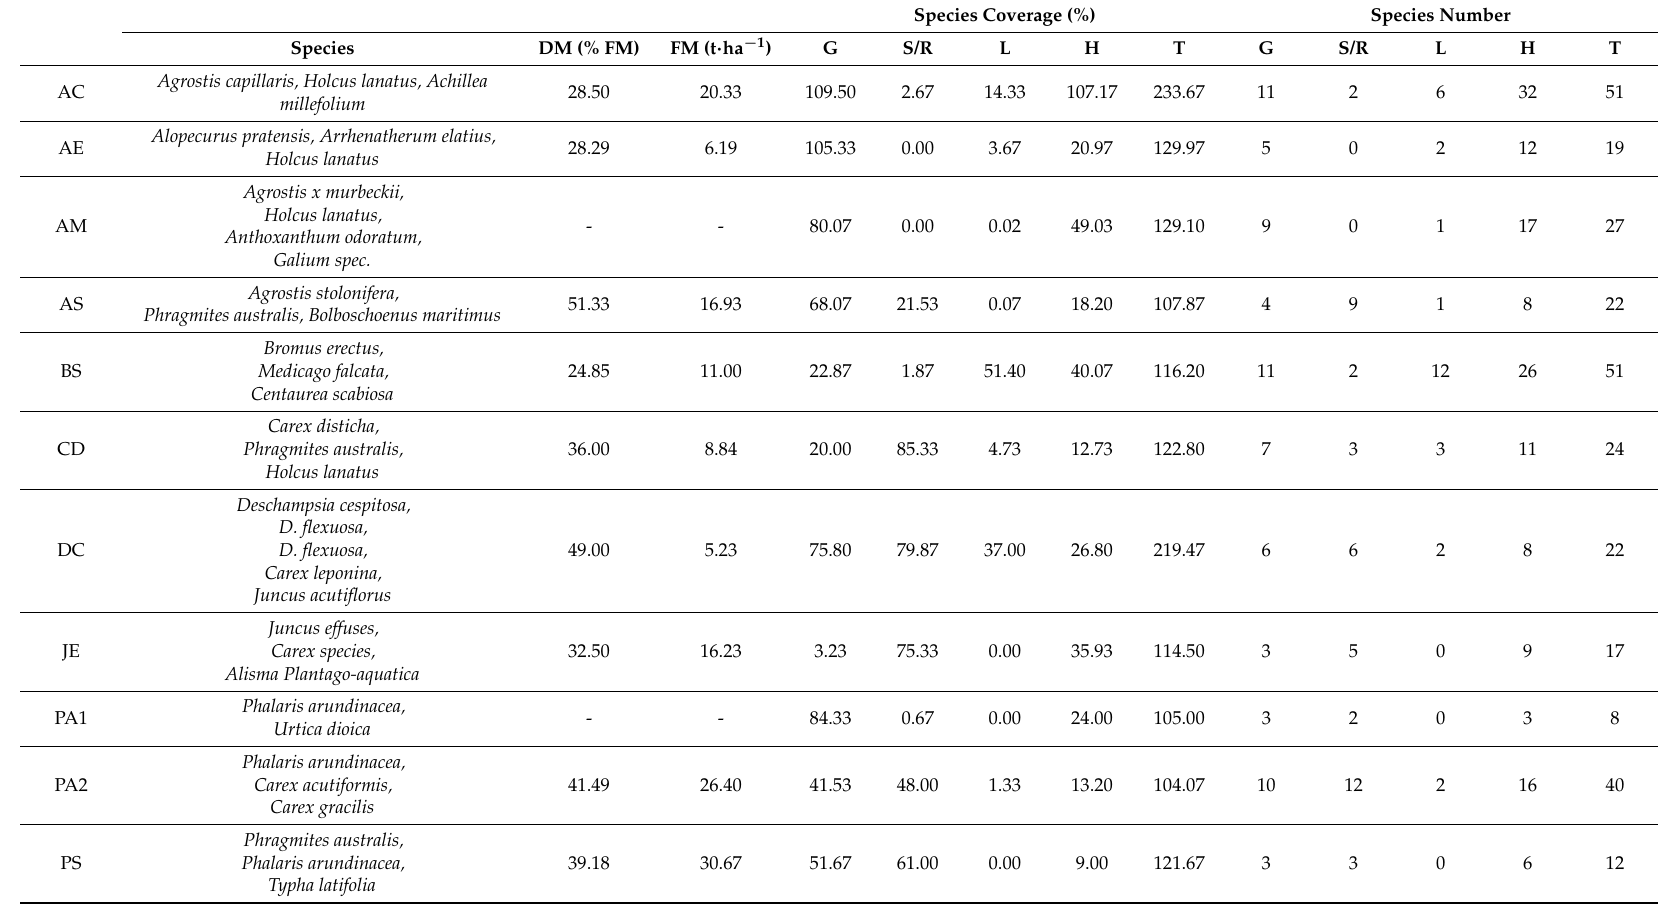
Table A1. Detailed botanical parameters of the samples including the dominant species, species coverage and species number for each